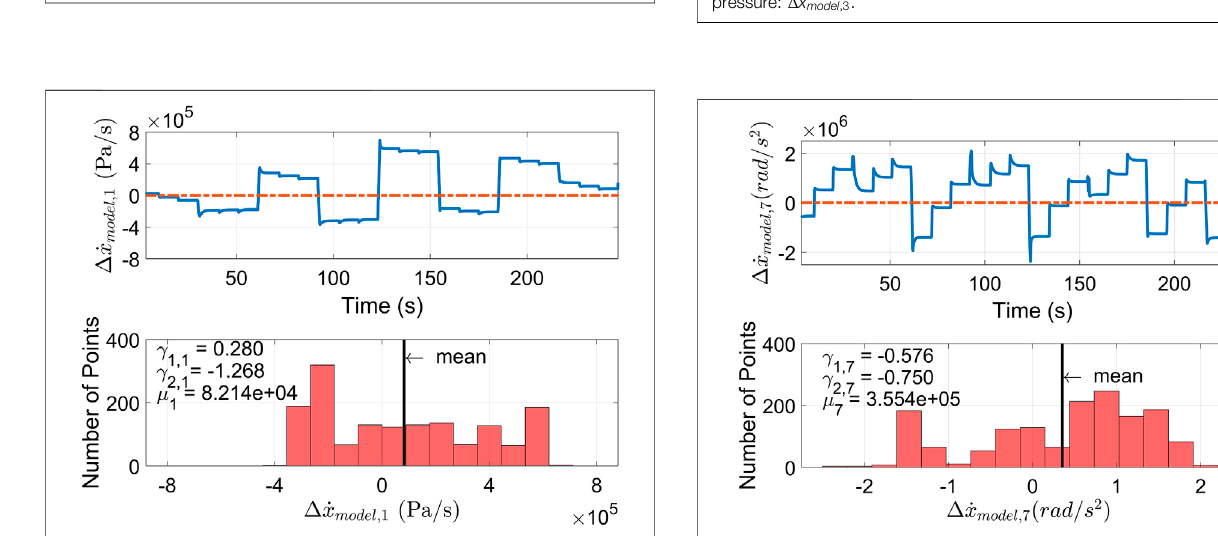
FIGURE 6 | Unknown disturbance estimation for exhaust manifold pressure: Δ _ x model , 3 .